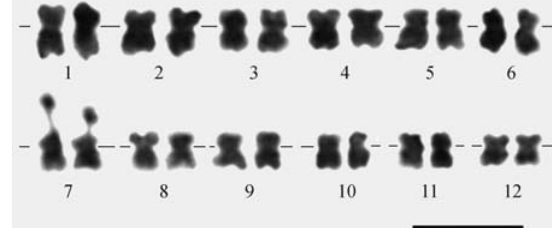
Figure 3 - Karyogram (2n = 24) of the Figure 2 chromosome set showing 12 submetacentric chromosome pairs, including chromosome pair 7 showing the secondary nucleolus organizing region (NOR) constriction) are shown. The gap in the short arm of pair 7 was produced by the stretch- ing of stalk of the satellite. The nucleolus was digitally removed from the original image. Bar = 5 (cid:1)